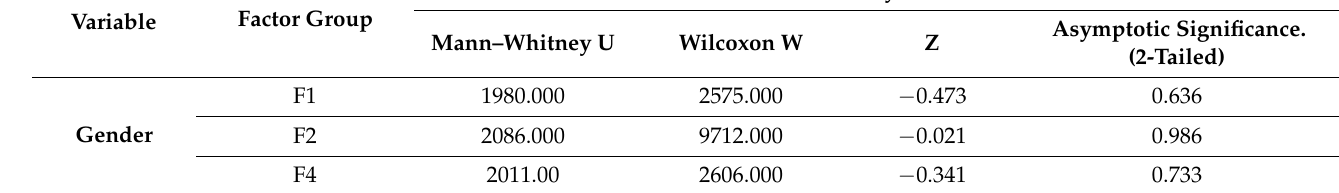
Table 8. Results of Mann–Whitney U test. Source: composed by the authors by using IBM SPSS Statistics 26 (Armonk, NY: IBM